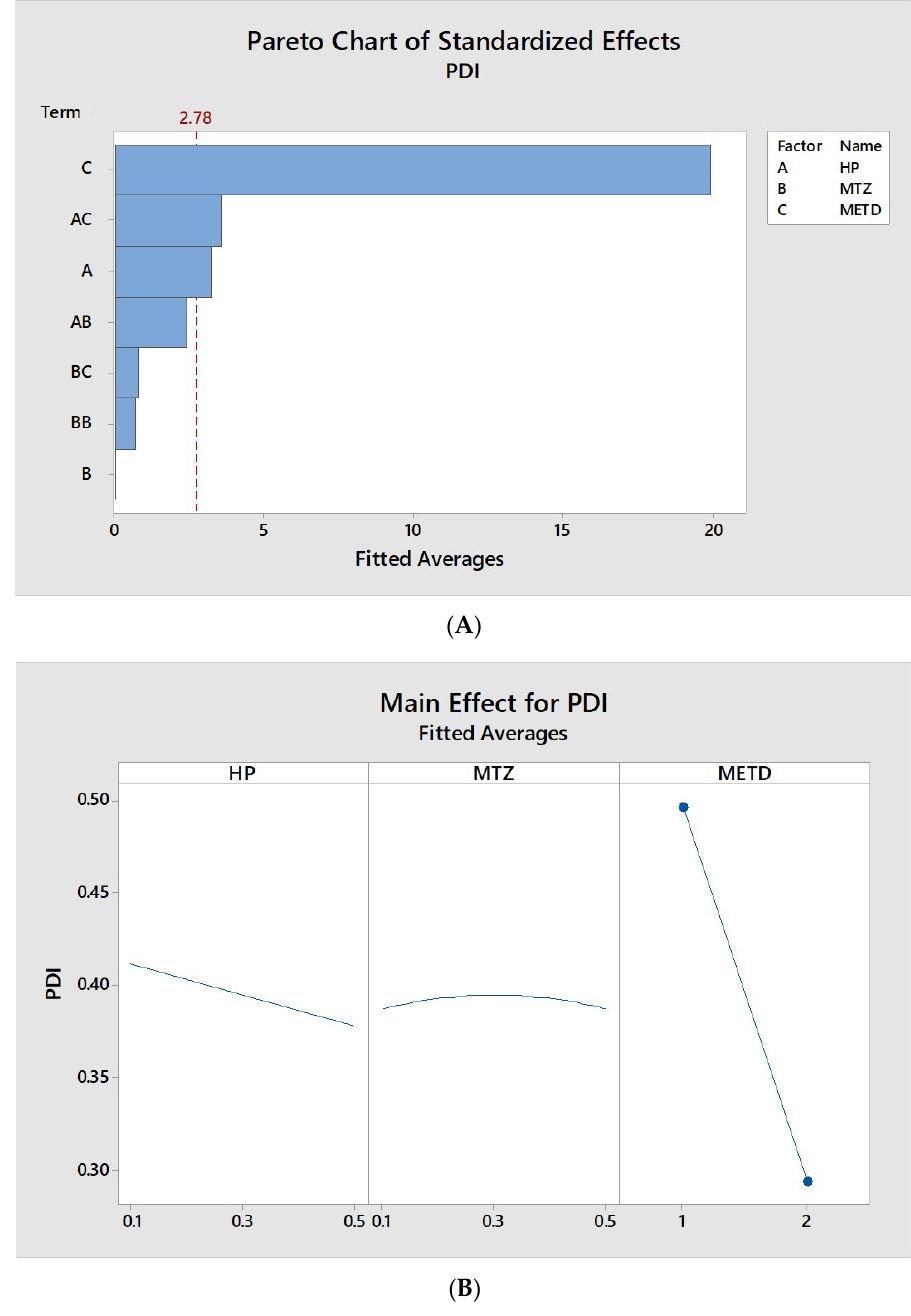
Figure 4. Graphic representation of factor influences on average zeta potential of particles. ( A )